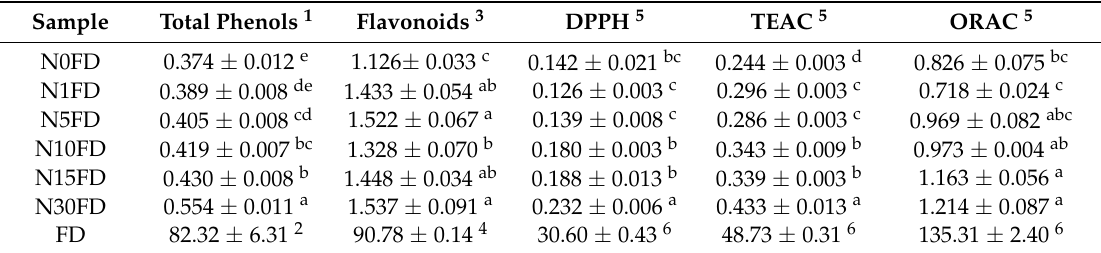
Table 5. Phenolic compounds and antioxidant capacity * of non-supplemented apple nectar (N0FD), apple nectar supplemented with 1 g/L (N1FD), 5 g/L (N5FD), 10 g/L (N10FD), 15 g/L (N15FD) or 30 g/L (N30FD) of freeze-dried araç á -boi and reconstituted freeze-dried araç á -boi. Three